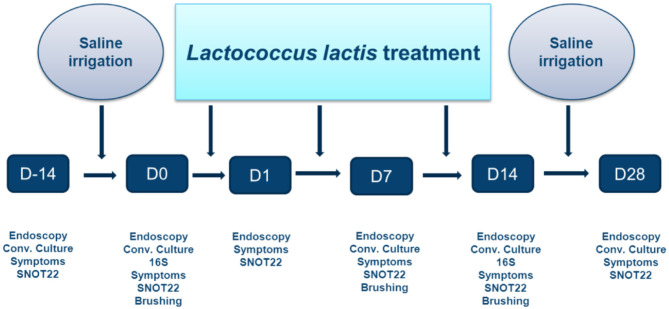
Timeline of probiotic trial. Study protocol showing initial 14 days saline-only washout period; 14 days of L. lactis W136 followed by 14 day saline-only observational period (D, Day).